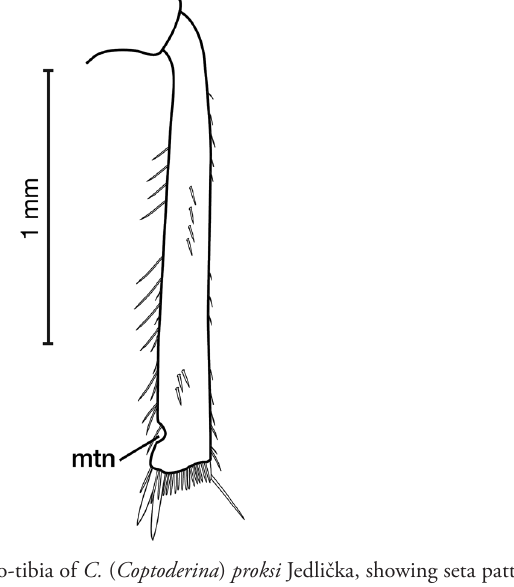
Legs . Fig. 53. Two rows of small squamo-setae on tarsomeres 1–2 of mid-leg, finer